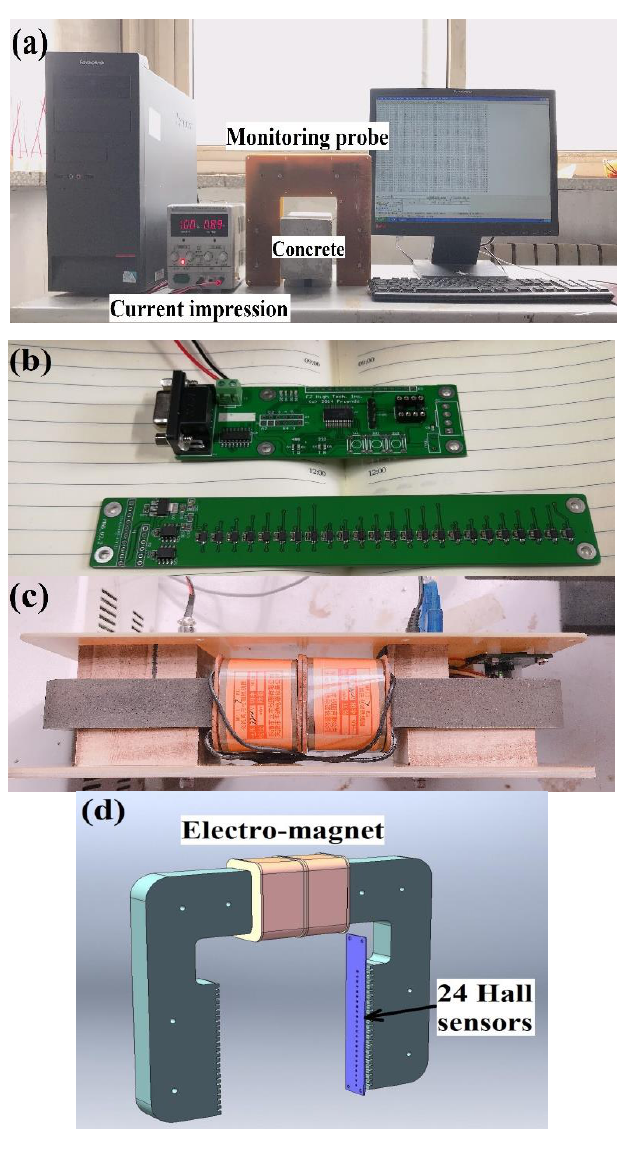
Figure 3. Electromagnetic monitoring apparatus (EMMA) diagram: ( a ) front view, ( b ) linear arrangement of 24 Hall effect sensors, ( c ) electromagnet (top surface), and ( d ) schematic diagram of monitoring probe.